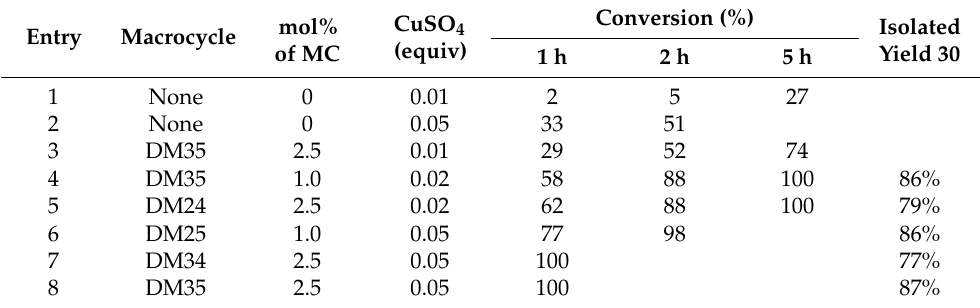
Table 4. Effect of the macrocycles on CuAAC of sugar azide with